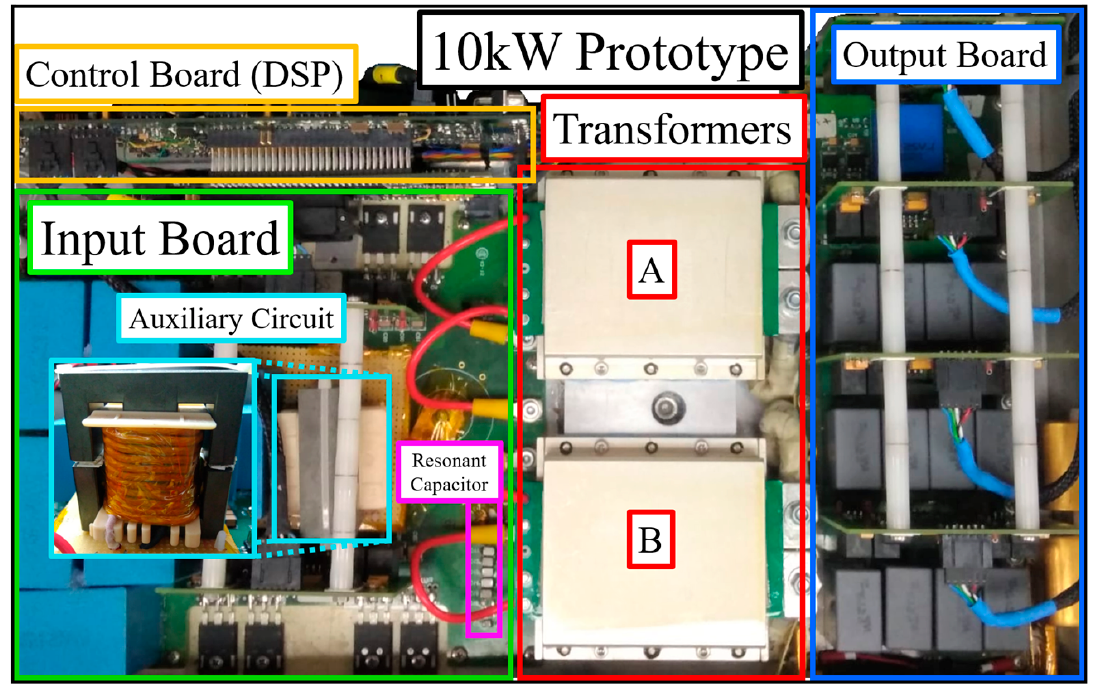
Figure 23. 10 kW Figure 23. 10 kW prototype.